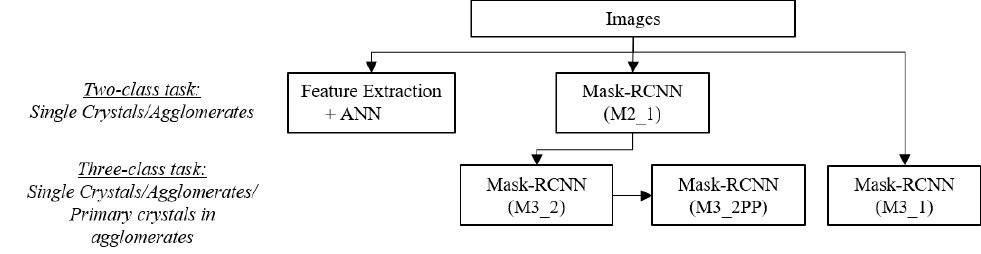
Figure 2. Overview and systematics of methods developed or evaluated in this study.